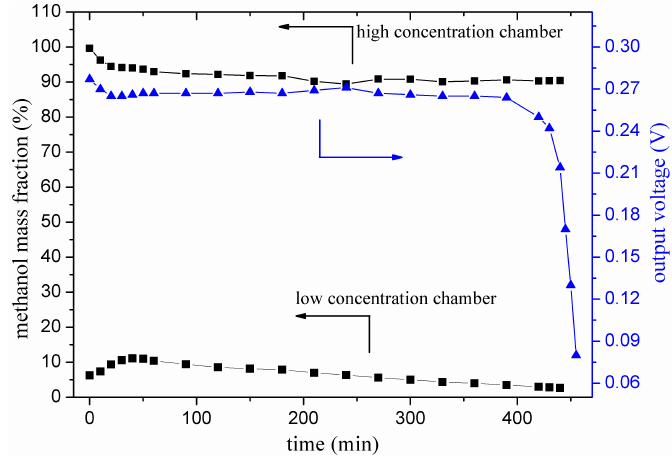
Figure 6. Stability tests of the μ -DMFC operating at 30 mA.